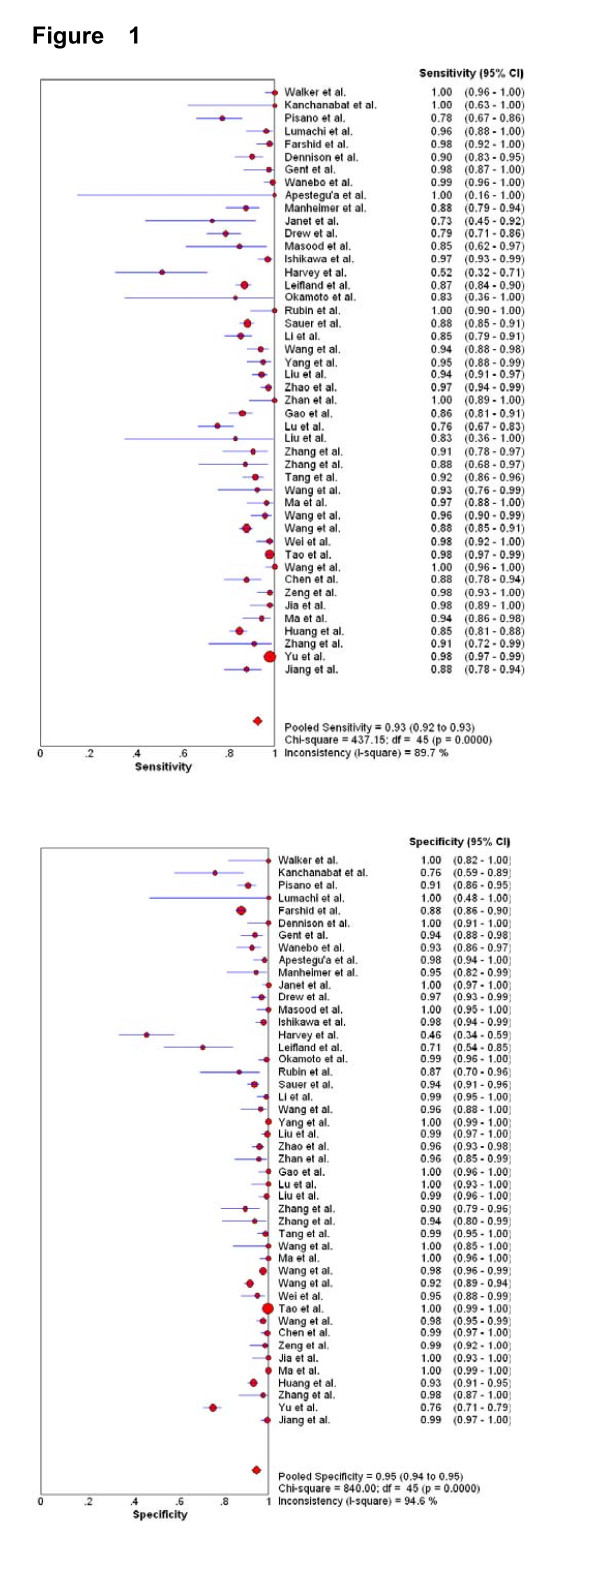
Forest plot of estimates of sensitivity and specificity for FNAB (C1 was temporarily exluded) in the diagnosis of breast cancer. The point estimates of sensitivity and specificity from each study are shown as solid circles. Error bars are 95% confidence intervals. The authors' names indicate the studies.